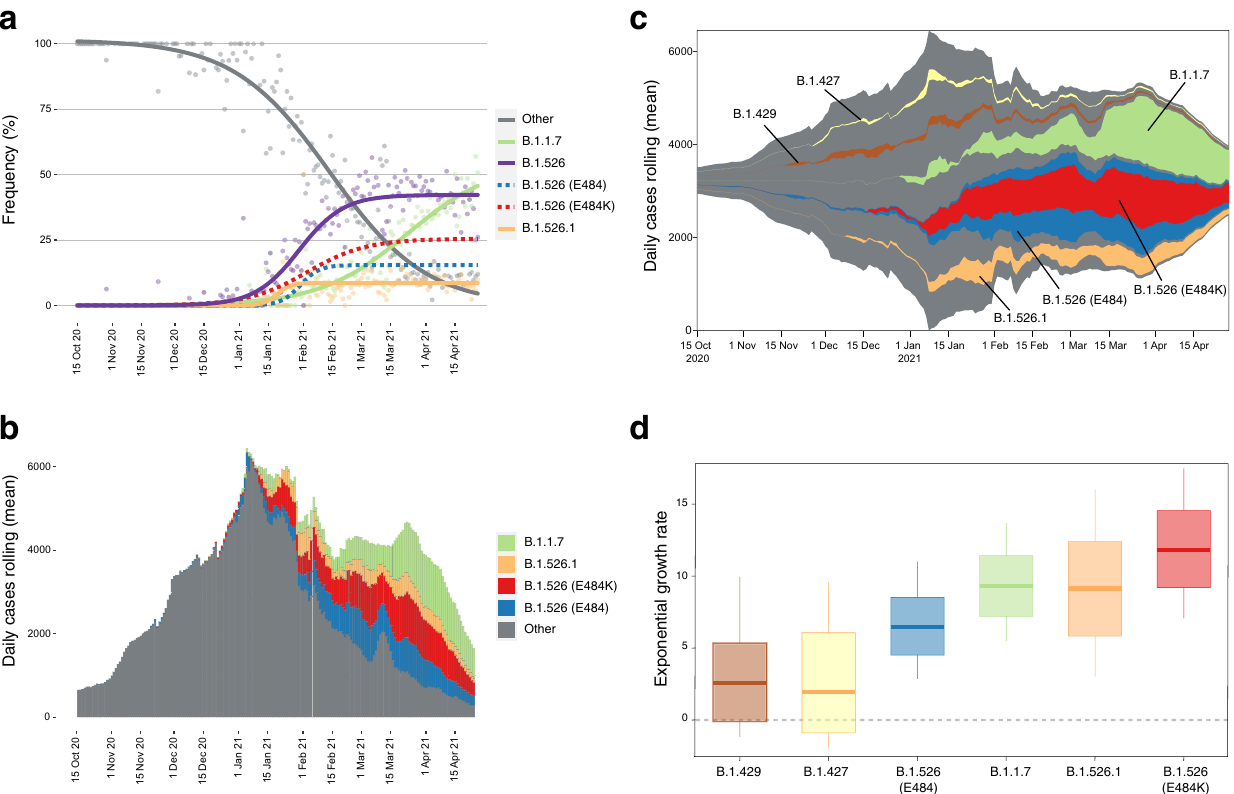
Fig. 3 Rise of SARS-CoV-2 variants in New York City (NYC) in late 2020 and early 2021. a Daily frequency (points) and logistic regression trendline for B.1.1.7 (green line), B.1.526 (including B.1.526.2; purple line), B.1.526.1 (orange line), Other (all other sampled SARS-CoV-2 genomes; gray line). Also displayed is the logistic regression for B.1.526 samples with E484K mutation (red dotted line) and without (blue dotted line). b Rolling mean number of B.1.526.1 (orange), B.1.526 E484K (red), B.1.526 E484 (blue). c Muller plot depicts prevalence of lineages over time displaying rolling mean of